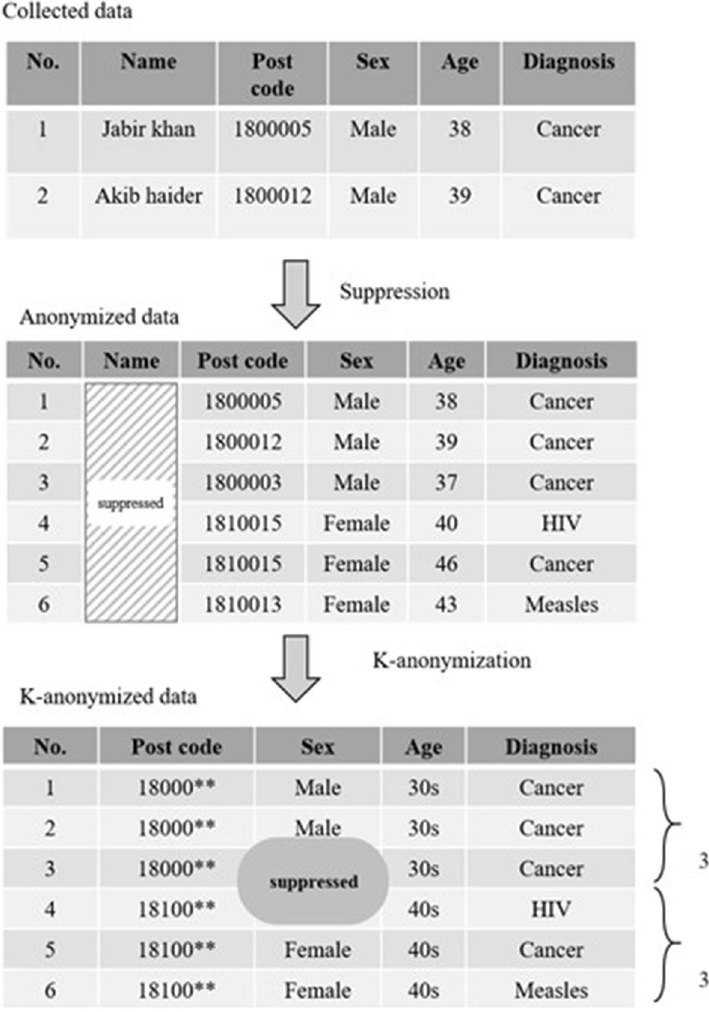
Fig. 8 Illustration of generalization